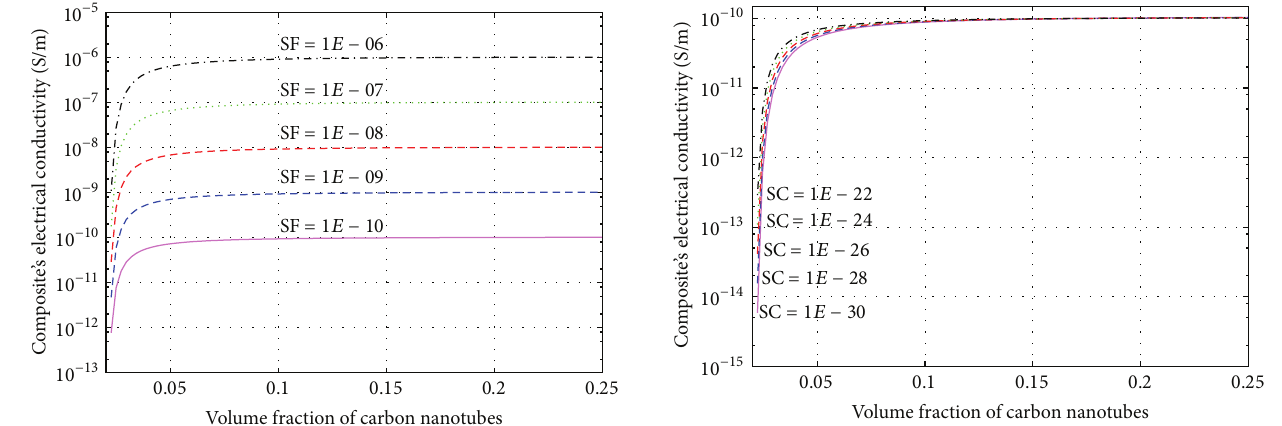
Figure 16: DC electrical conductivity of the nanocomposite when the conductivity at the maximum packaging fraction is varied (Mamunya’s model).